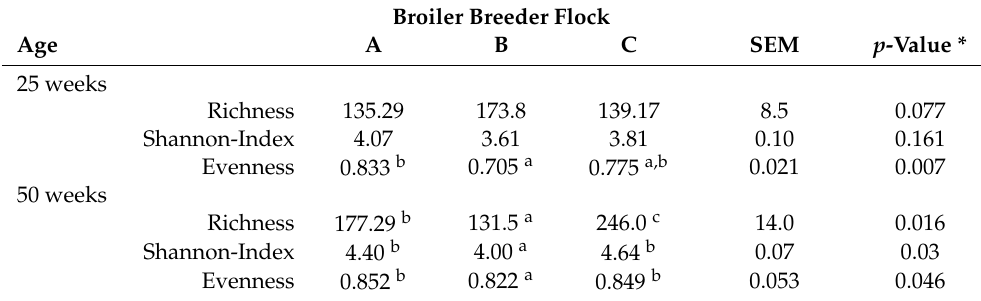
Figure 1. Principal component analysis on the whole 16S rDNA data set visualizing differences between flocks (A, B, C) and animal age (25 and 50 weeks of age). Different flocks are indicated by different colors, while timepoint 25 is displayed as circle and timepoint 50 as square. The prediction eclipses show a p = 0.95 probability for new observations. Table 1. Bacterial diversity indices in caecal samples of broiler breeders in different